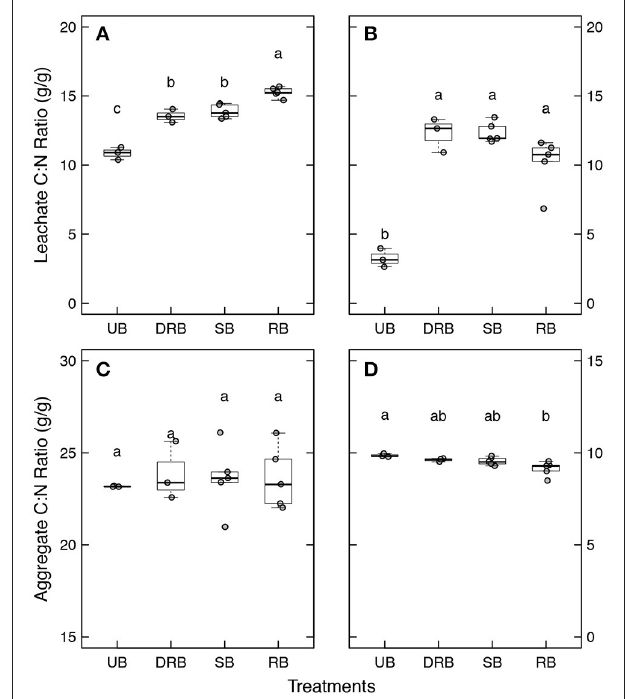
FIGURE 2 | Carbon to Nitrogen ratio (C:N) of the water extractable organic matter (A,B) and the whole aggregates (C,D) for the forest (A,C) and shrubland (B,D)